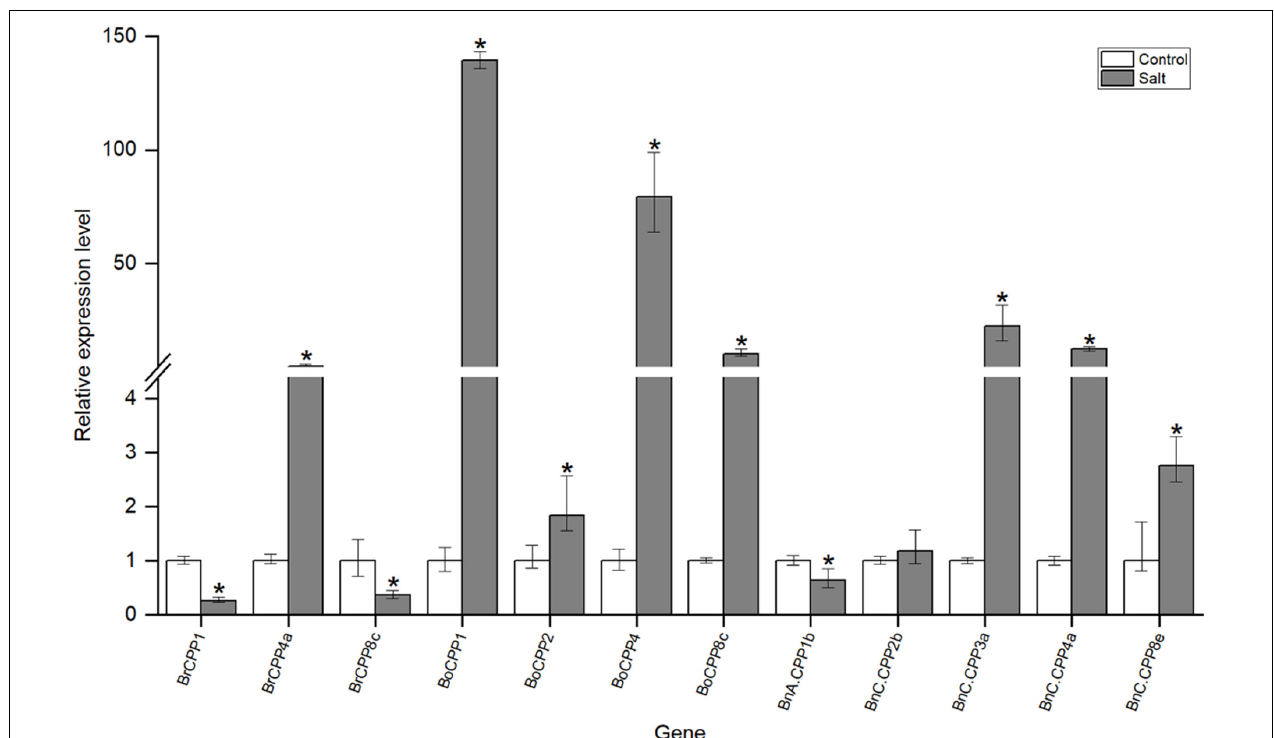
FIGURE 7 | Expression of CPP genes in leaves of B. rapa, B. oleracea, and B. napus . Control: the control group; Salt: salt treatment group; “*” represents a significant difference between the two